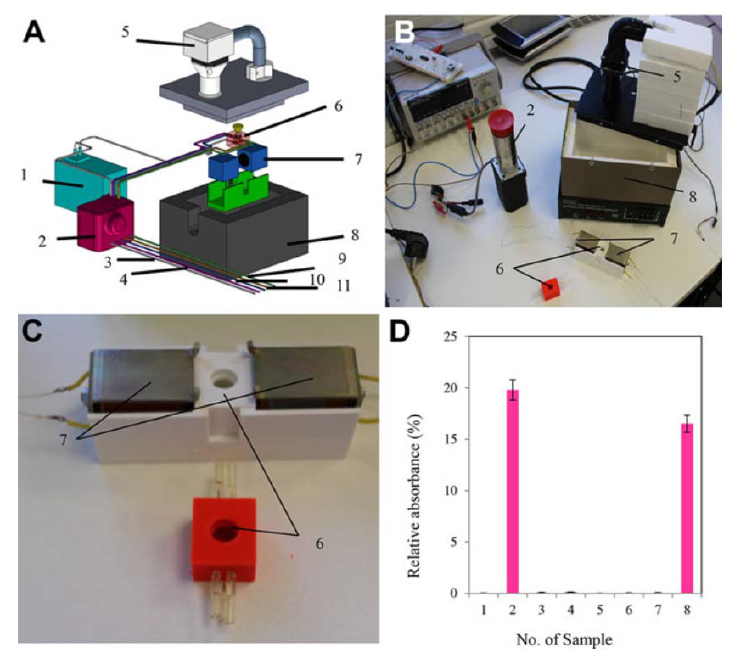
Figure 12 . ( A ) Scheme of 3D ‐ printed chip for detection and confirmation of MRSA presence using binding of MRSA to the gold nanoparticles with specific primers in the chip; ( B ) system for